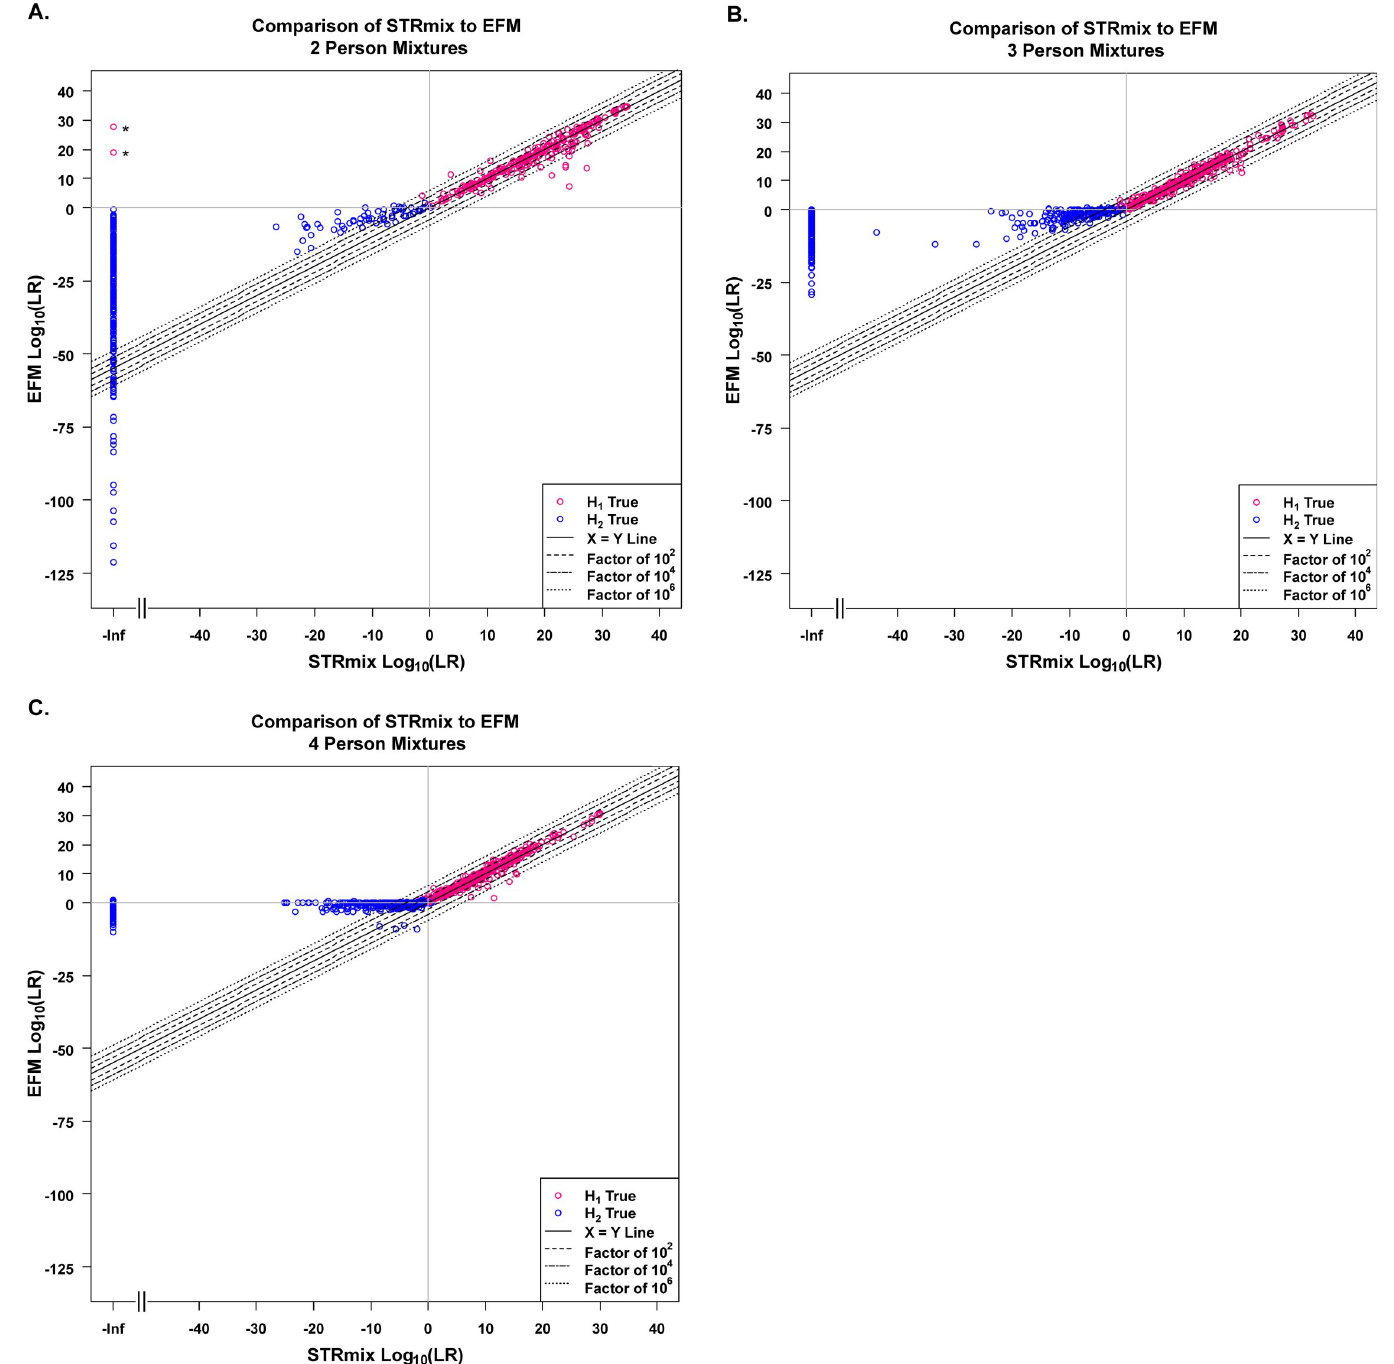
Fig 5. Global overall profile H1-true test and H2-true test log 10 (LR) values assigned by STRmix and EFM. �� in (A.) are the two 2P H1-true test interpretations for which STRmix assigned profile LRs of 0 (plotted in magenta at–Infinity (-Inf) on the log 10 scale and discussed in detail in Section 3.6).